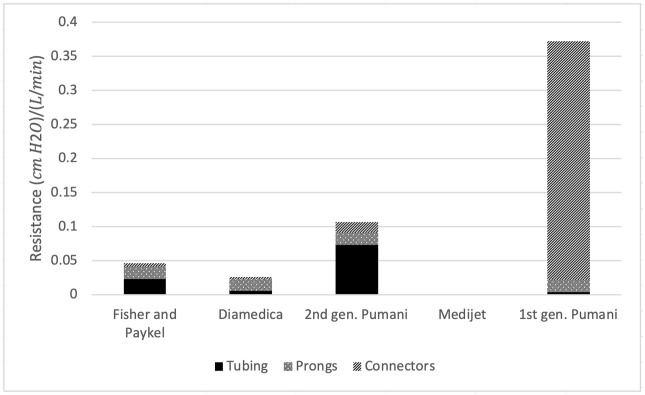
Theoretical contributions of tubing, prongs, and connectors to calculated resistance.Height of the bars indicates measured resistance of the expiratory limb for each CPAP system. Theoretical contribution of system tubing (solid), prongs (dotted), and connectors (diagonal lines) are shown. Data in S2 Table.